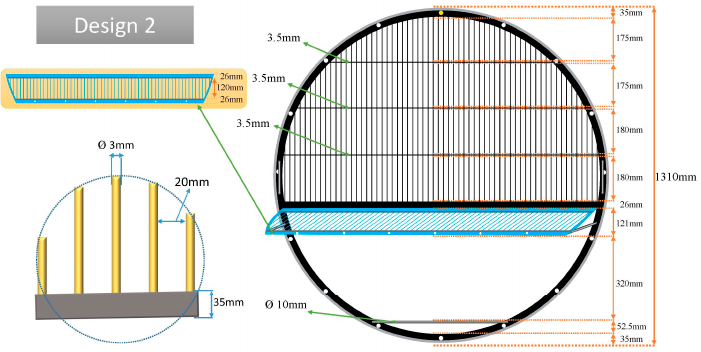
Figure 3. Second JTED sorter design for Taiwanese bottom trawlers with single boat bottom otter trawls.